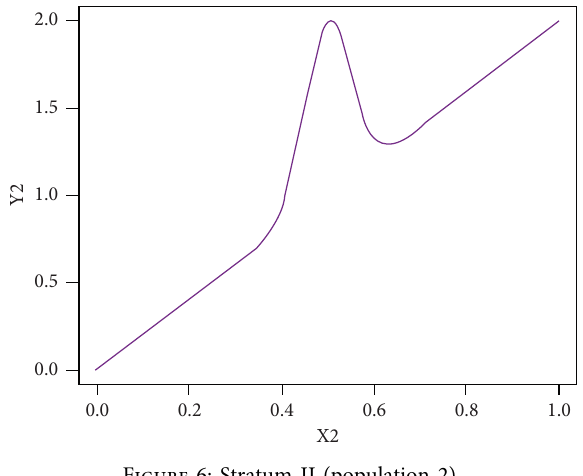
Figure 6: Stratum-II (population-2).